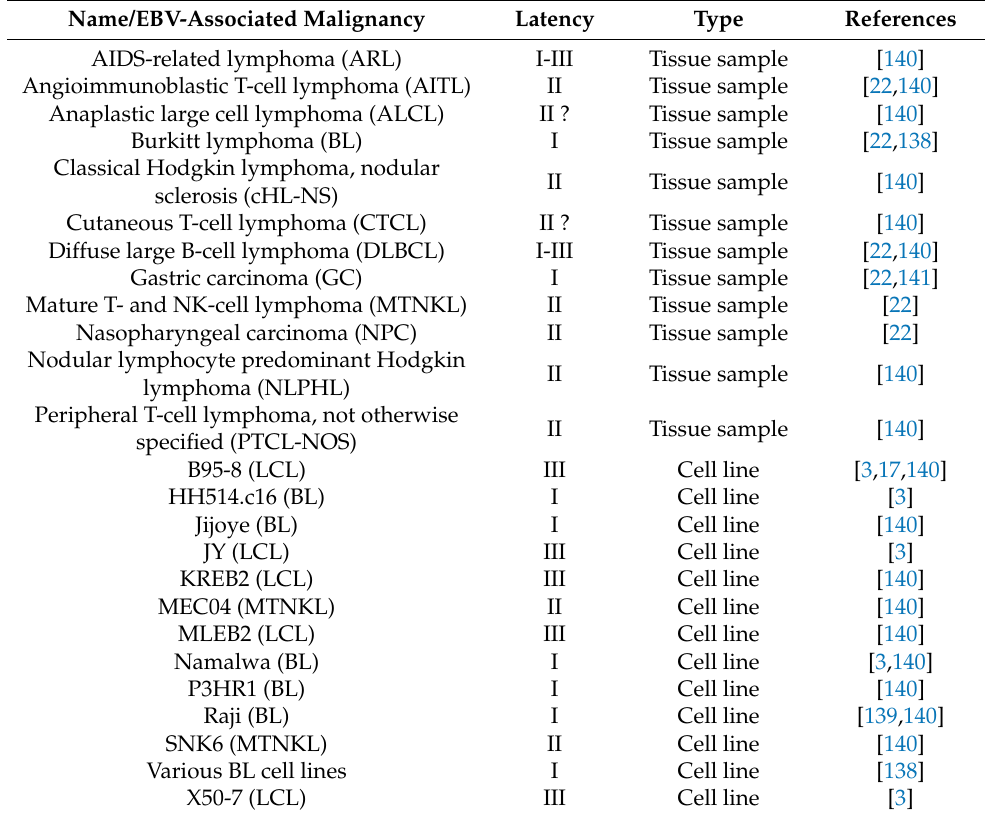
Table 3. Summary of cell lines and tissue samples with detected BILF1